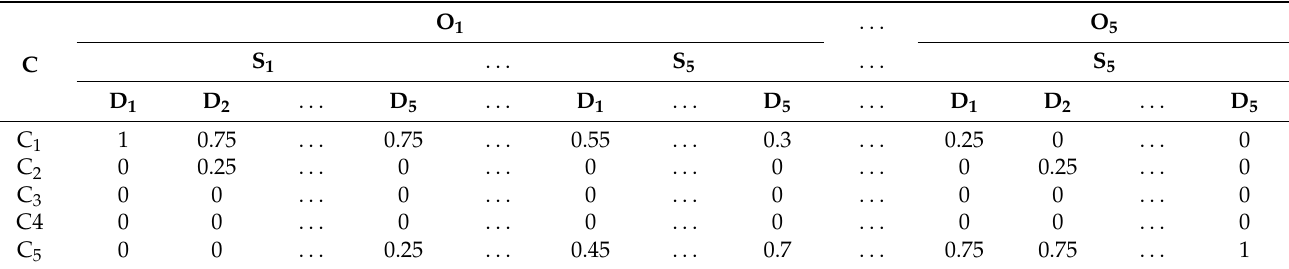
Table 10. BN conditional probability